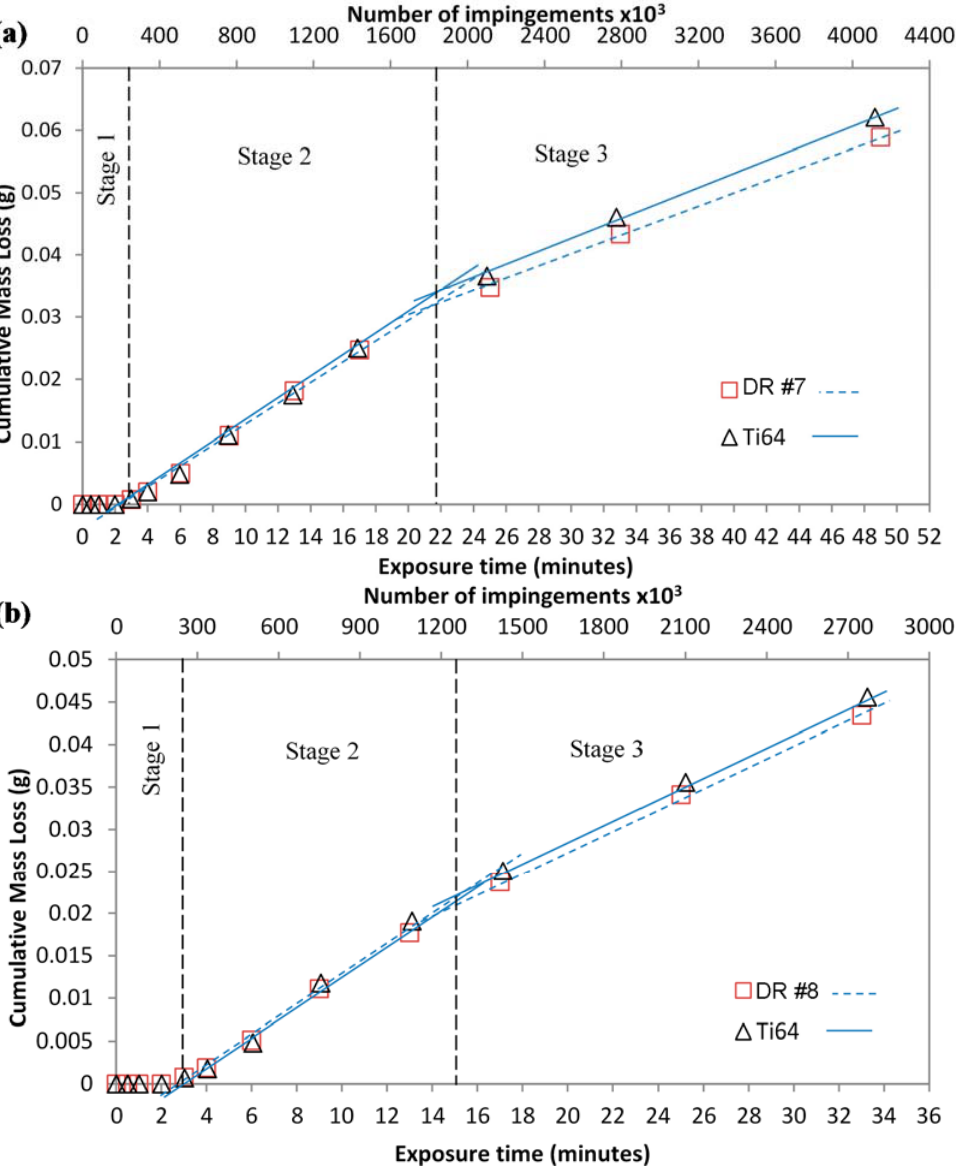
Figure 11. Erosion curves of ( a ) DR #7; and ( b ) DR #8 with reference Ti64 under 460 µm droplets and 350 m/s